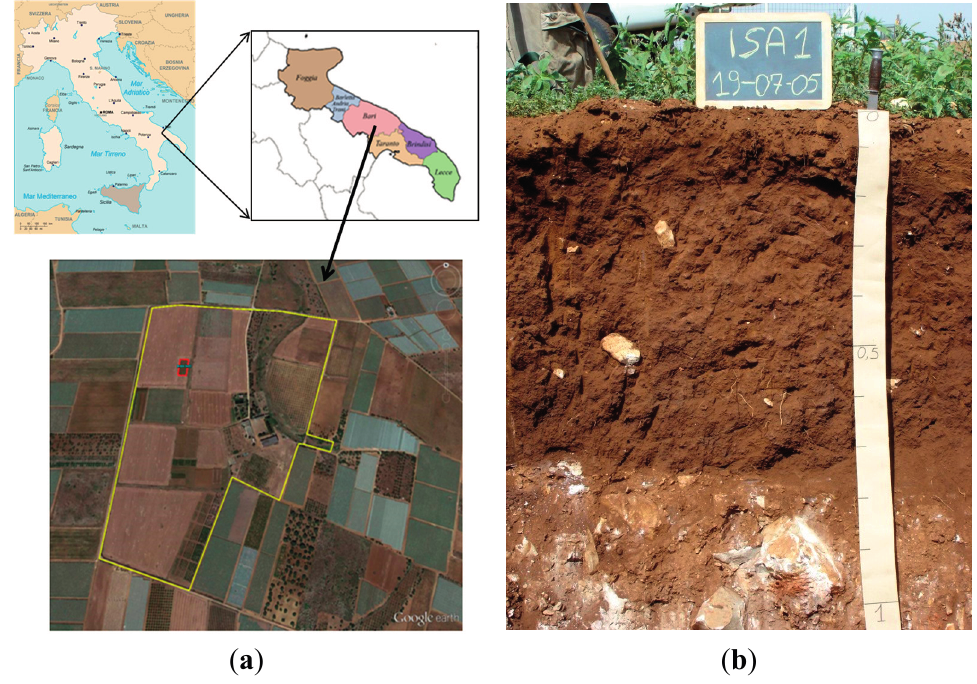
Figure 1. ( a ) The experimental farm (yellow polygon) located in Apulia region (south-eastern Italy) and the experimental test plot delimited by a red rectangle [18]; ( b ) Pedological